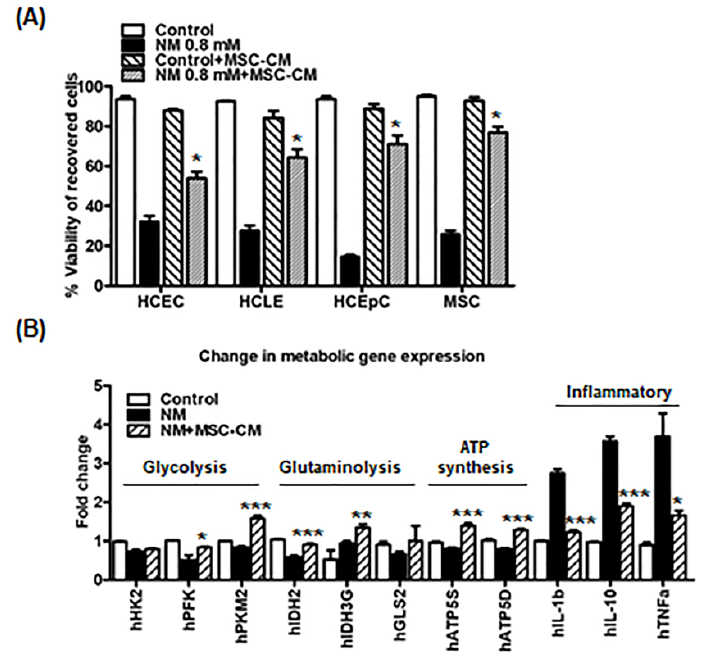
Figure 2. Mesenchymal Stromal Cell (MSCs)-conditioned media recovers immediate cytotoxic ef- fects in the corneal epithelial cells following exposure to nitrogen. ( A ) Cell viability of recovered cells is measured by trypan blue staining with control, NM 0.8 mM, control media + MSC-CM, and NM 0.8 mM + MSC-CM. *** p < 0.001 vs. NM 0.8 mM. ( B ) Graph showing the mRNA levels of genes for glycolysis, glutaminolysis, ATP synthesis, ATP synthesis, and inflammatory genes in control, NM 0.8 mM (2 h), and NM 0.8 mM (2 h) + MSC-CM (24 h) by performing qPCR. HCEC cells are used for NM treatment. * p < 0.05, ** p < 0.01, *** p < 0.001 vs. NM treated group.